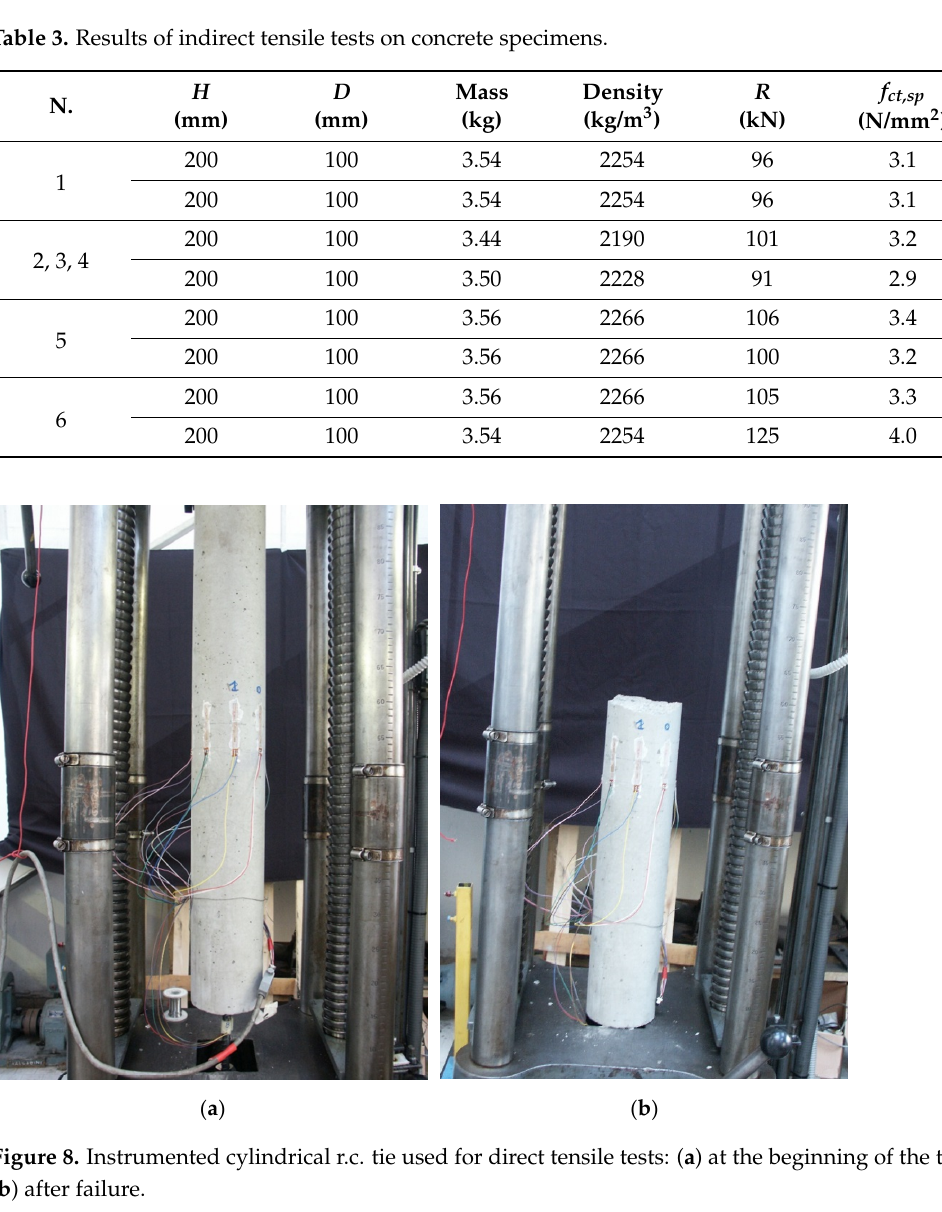
Table 3. Results of indirect tensile tests on concrete specimens.